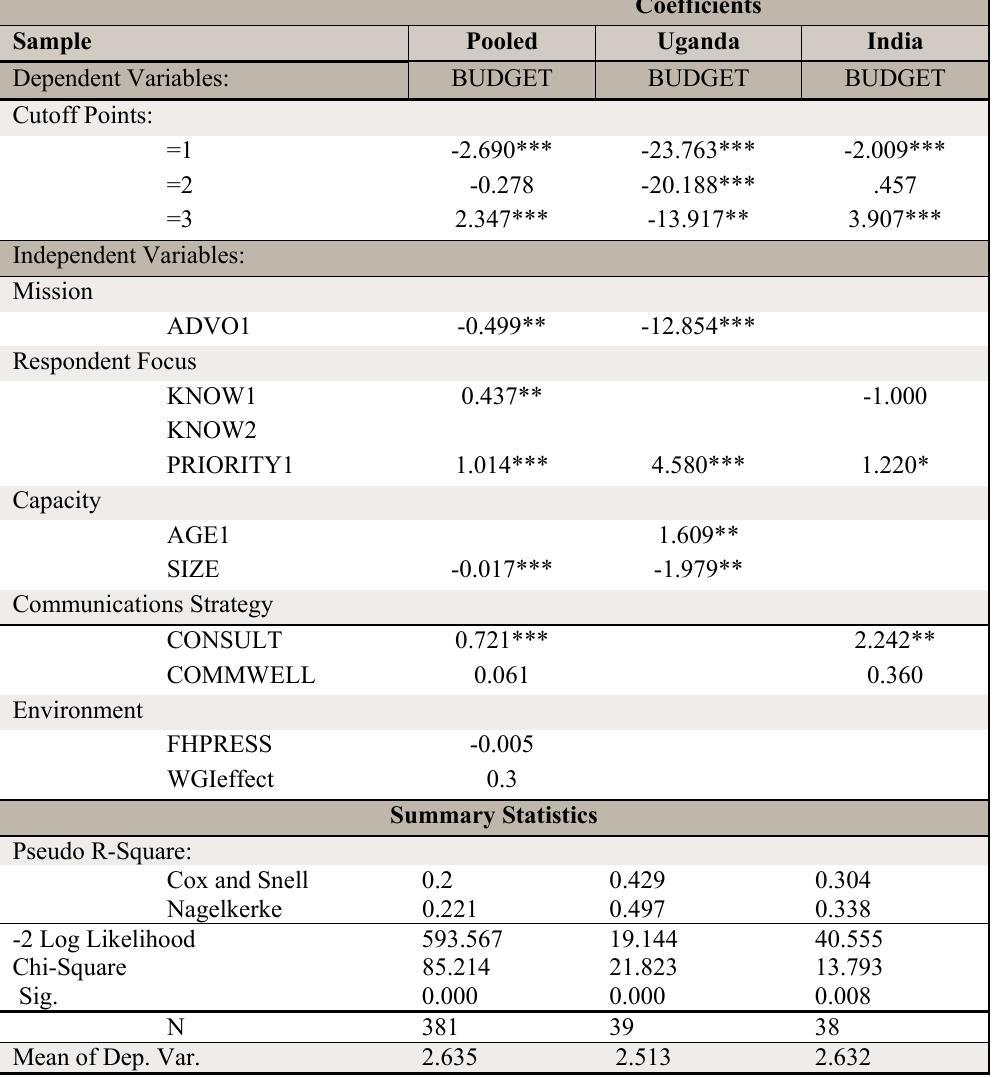
Table 6. Estimated Models for BUDGET Using Pooled, India, and Uganda Samples